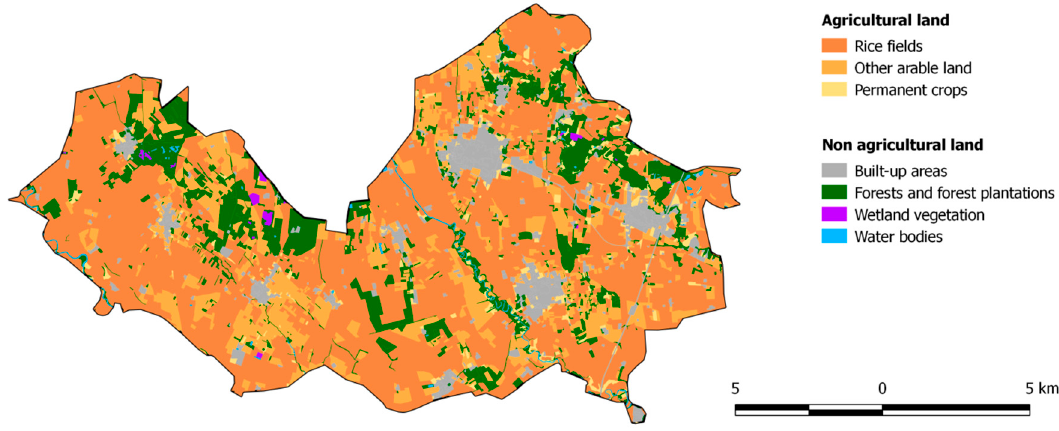
Figure 2. Land use in the selected area (source: own elaboration on DUSAF [42]).